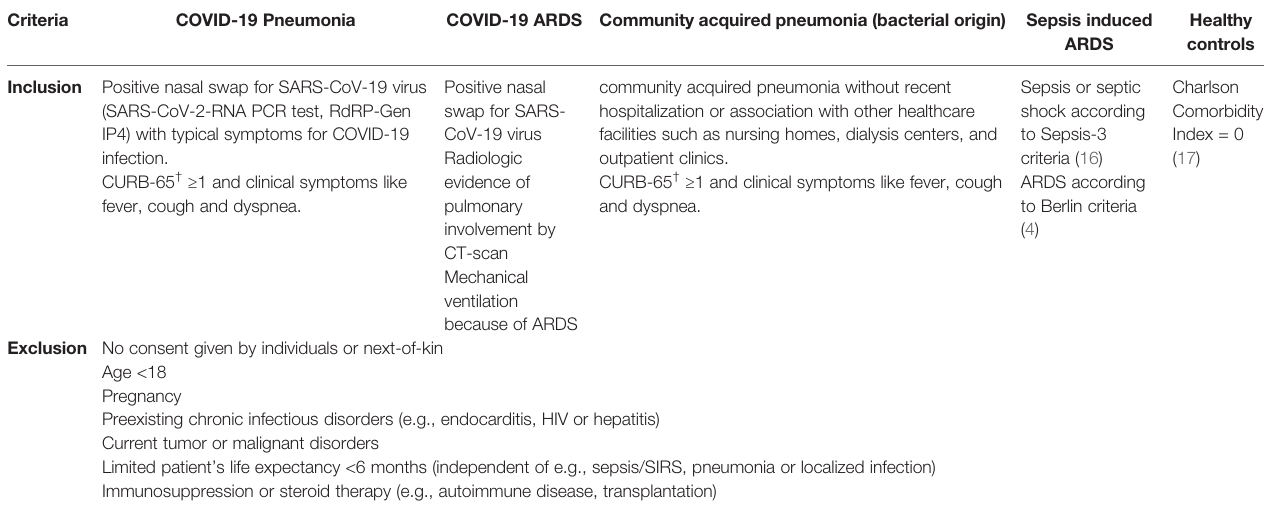
TABLE 1 | Study inclusion and exclusion criteria according to study groups.